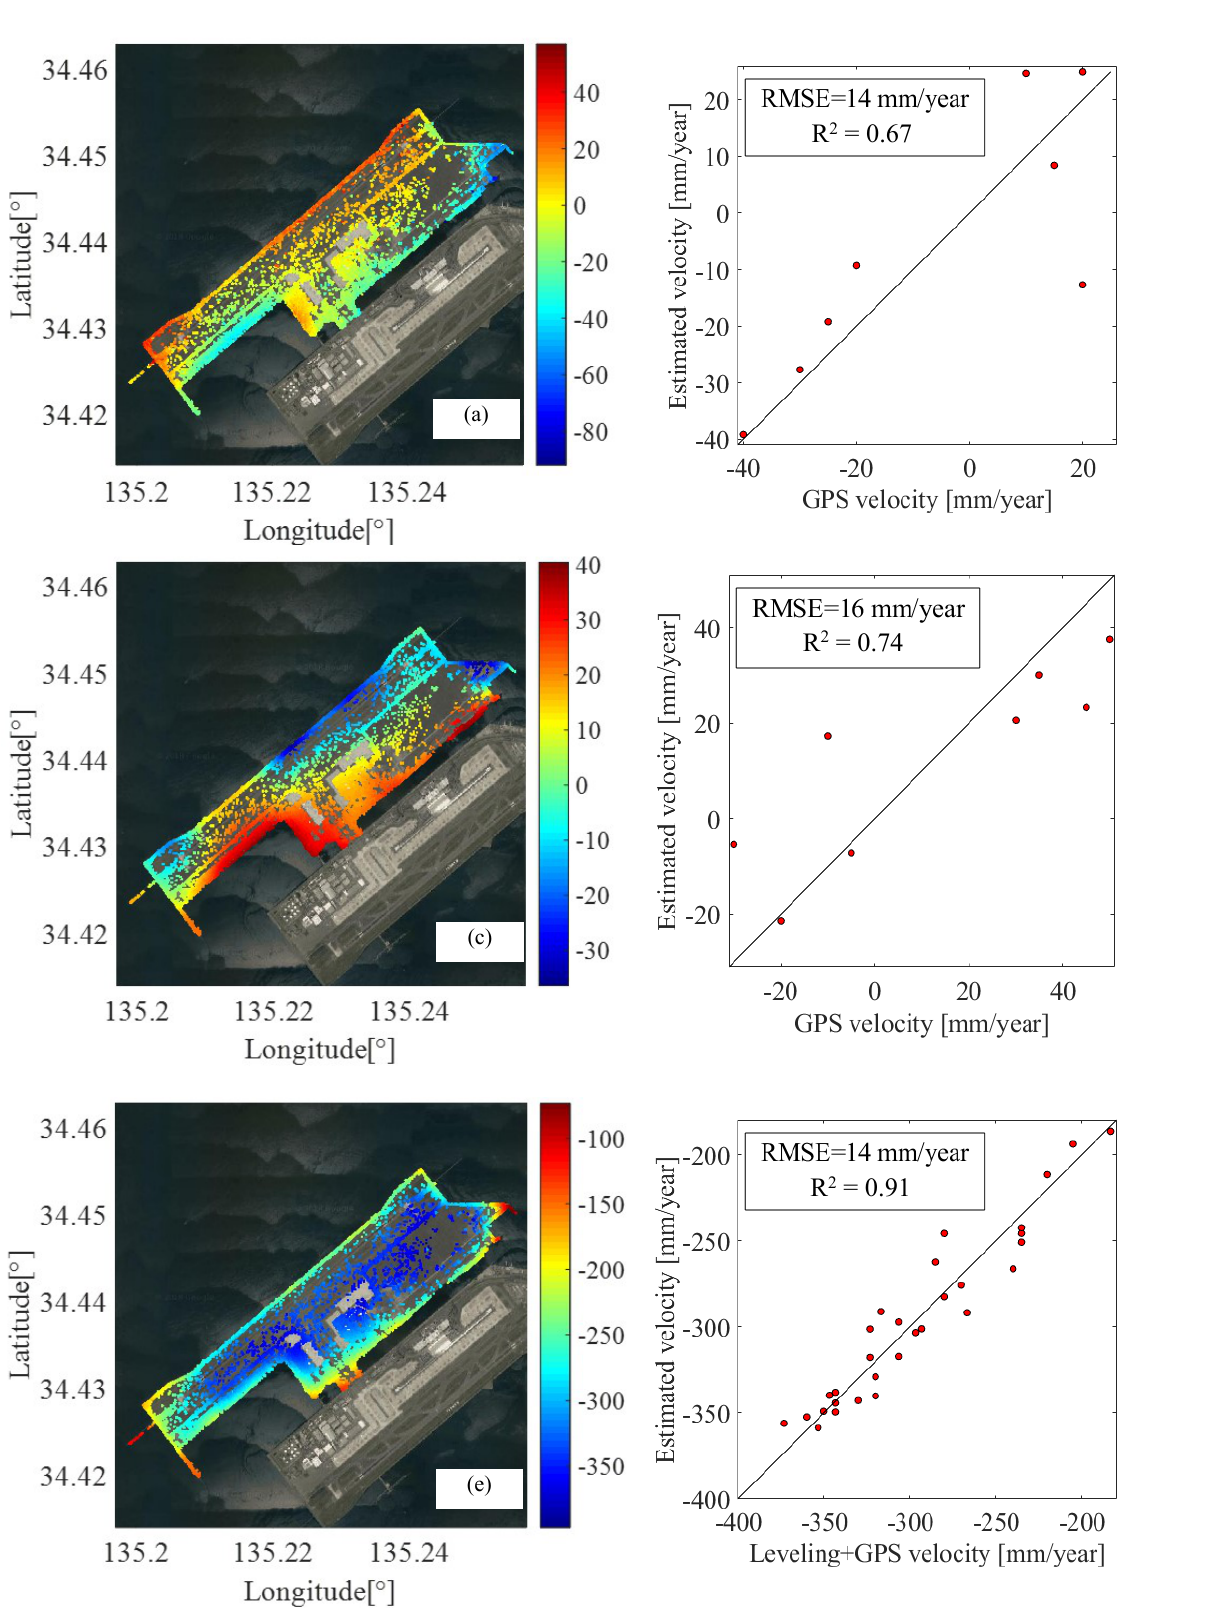
Figure 7. Integration results: (a) east–west, (c) north–south, and (e) vertical components of displacement shown in units of mm/year. Validation results: (b) east–west, (d) north–south, and (f) vertical components. Map data ©2018 Google,